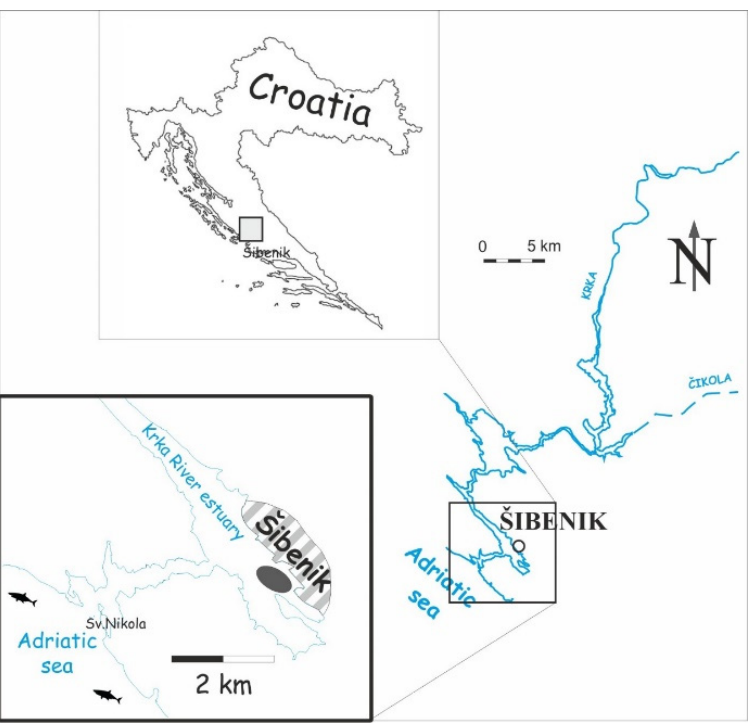
Figure 1. Map of the study site; dark ellipse indicates sampling area. Salinity was measured with a refractometer at the surface (15) and at the halocline (31). The average vessel speed was 3 km/h and the duration time for towing was 5 min. Volume-reduced samples of the SL were obtained by submerging only half of the “Net for Microplastic Sampling” (Hydro-Bios, Apparatebau GmbH, Altenholz, Germany; mesh size: 300 µm; net aperture: 0.28 m 2 [width 70 cm, height 40 cm, length 260 cm]). SBL samples were obtained by fully immersing the “Net for Microplastic Sampling” which sampled the first 40 cm of the water column. For sampling at the freshwater-seawater interface (halocline layer (HL), depth 1.5 m), a scuba diver controlled the net. For the marine layer (ML) (2 m), the net was towed without buoys. A total of 12 samples were collected, 3 replicates for each layer in the water column. An average of 166.95 m 3 of seawater was